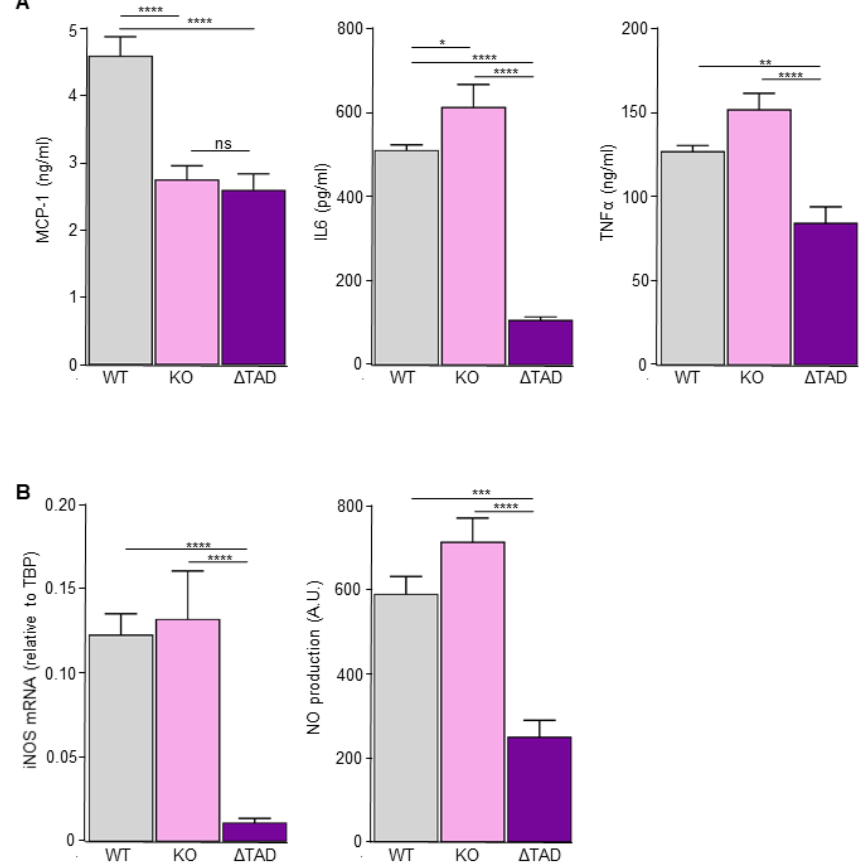
Figure 3. LPS-induced inflammatory and antibacterial response in wild-type (WT), C/EBP δ knock- out (KO) and C/EBP δ TAD mutant ( Δ TAD) macrophages. ( A ) MCP-1, IL-6 and TNF α levels deter- mined by ELISA in the supernatant of RAW264.7 macrophages stimulated with 100 ng/mL LPS for 24 h. ( B ) iNOS mRNA expression (left panel) and NO production (right panel) by RAW264.7 mac- rophages stimulated with 100 ng/mL LPS for 24 h. Shown is the mean ± SEM of three independent experiments performed with two individual wild-type, Δ TAD and KO clones. *: p < 0.05; **: p < 0.01; ***: p < 0.001; ****: p < 0.0001. 3.4. Discordant Transcriptional Programs in C/EBP δ Deficient and C/EBP δ Transactivation Domain Mutant Macrophages To fully appreciate the difference in gene expression between C/EBP δ knock-out and Δ TAD macrophages, we next performed RNAseq analysis on unstimulated naïve wild-type, knock-out and Δ TAD macrophages. Principal component analysis shows that the different macrophage subsets form well-separated clusters with no overlap between knock-out and Δ TAD macrophages (Figure 4A). The correlation heatmap shown in Figure 4B confirms the divergent gene expression patterns between the macrophage subsets, but it also suggests that C/EBP δ knock-out and Δ TAD macrophages are somewhat more strongly correlated with each other than with wild-type macrophages. On the individual gene level, a similar number of genes is downregulated in C/EBP δ knock-out and Δ TAD macrophages (i.e., 1425 and 1438, respectively). Of note, however, is that only approximately 60% (868) of the genes downregu- lated in C/EBP δ knock-out macrophages are also downregulated in Δ TAD macrophages. Of the remaining 557 genes downregulated in C/EBP δ knock-out macrophages, 546 genes are similar in wild-type and Δ TAD macrophages whereas 11 genes are even upregulated in Δ TAD macrophages compared to wild-type macrophages (Figure 4C). Similarly, a more or less equal number of genes is upregulated in both knock-out and Δ TAD macrophages (i.e.,